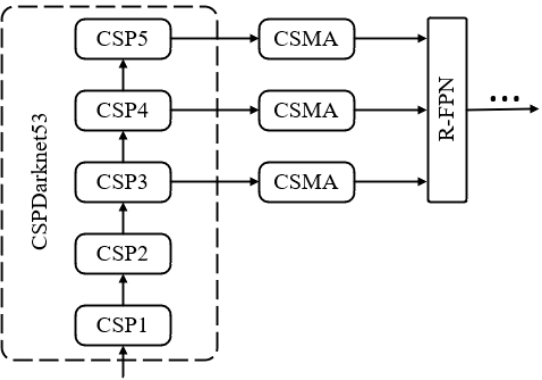
Figure 7. The position of CSMA. Table 1. Object Detection Result of Different Attention Method in VisDrone-DET2021